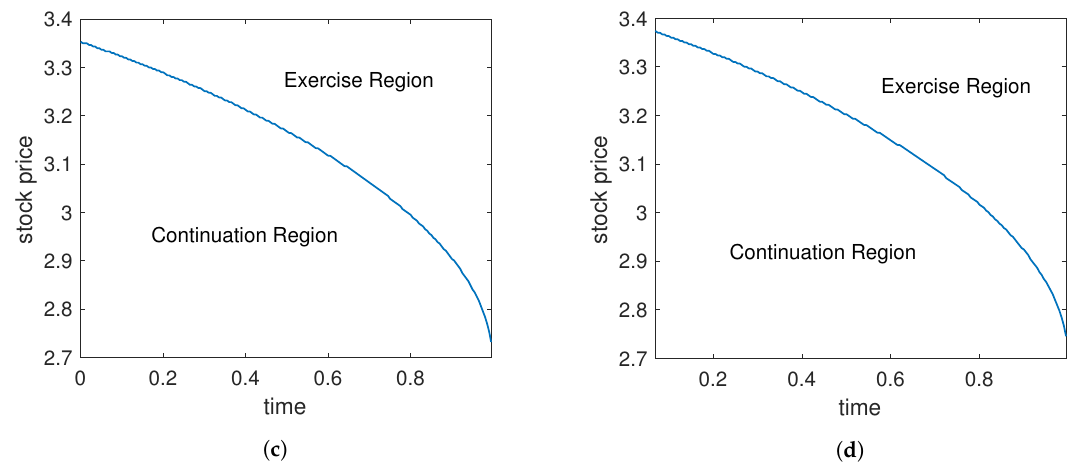
Figure 3. Optimal boundaries for selling stock under two-point discrete distribution ( a , b ), normal distribution ( c ) and double exponential distribution ( d ). Parameters for each plot are as follows: